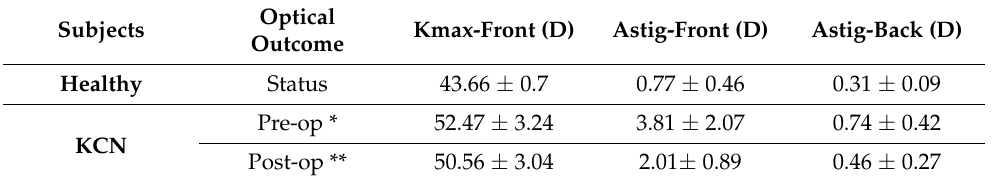
Table 2. Kmax-front, and the astigmatism of the anterior (Astig-front) and the posterior (Astig-back) corneal surfaces of the healthy controls and the patients (mean ± sd) obtained from Pentacam.